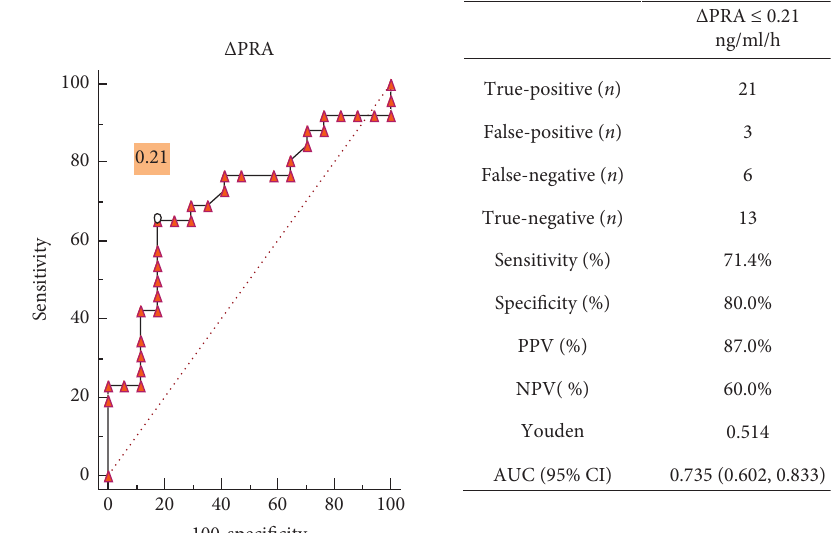
Figure 3: Receiver-operator characteristic (ROC) curves of Δ PRA for PA diagnosis among 43 patients with an inconclusive SITresult (28 with and 15 without PA) and relabelled by AVS. The optimal cutoff value was obtained according to the highest Youden index (YI): Δ PRA ≤ 0.21ng/ml/h (sensitivity � 71.4%; specificity � 80.0%; PPV � 87.0%; NPV � 60.0%; YI �